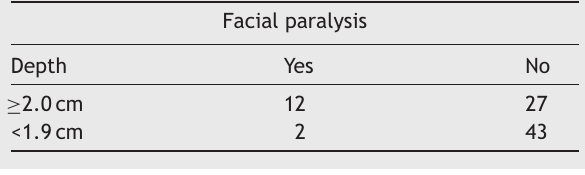
Case-control table --- tumor’s depth.